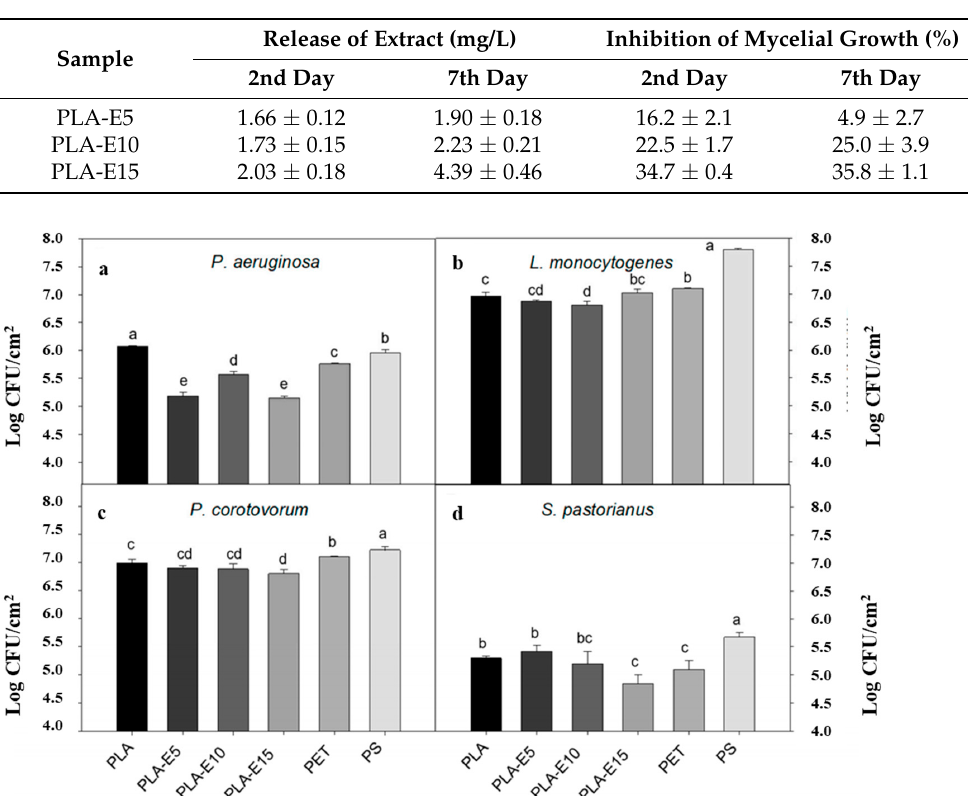
Figure 9. Adhesion of P. aeruginosa ( a ), L. monocytogenes ( b ), P. corotovorum ( c ), and S. pastorianus ( d ) microorganisms onto PLA, PLA-E films, polyethylene terephthalate (PET), and polystyrene (PS) samples. Ref. [99] , published by MDPI,